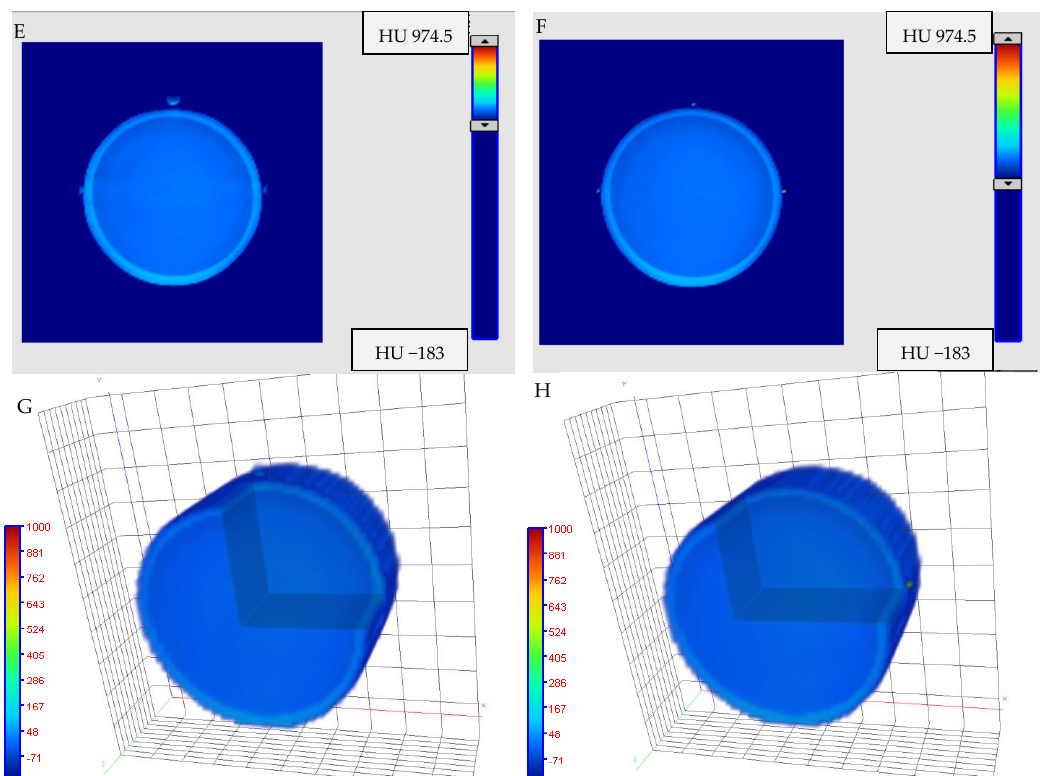
Figure 4. Two-dimensional (transversal plane, Z = −1 mm) and three-dimensional images of PH-6- DD2 container (GeVero Co.) with 5% gelatine (iCBCT, Pelvis, TrueBeam accelerator, Varian). The following markers were attached to the container at 0, 90 and 270°: steel wire commonly used as a marker in CT (1 mm thickness) ( A , C ), reflective marker spheres (Brainlab) ( B , D ), vitamin ( E ) of the shape of round capsules ( E , G ) and the shielded copper wire of the network cable (0.5 mm thickness) ( F , H ). The green circle in ( A ) indicates a cylindrical VOI of 32.8 mm in diameter and 2 mm long, applied to each scanned container with different markers. The red line in ( B ) is the position of the profiles applied to each scanned sample (see Figure 5). iCBCT images were processed with the polyGeVero-CT and polyGeVero (GeVero Co.) software packages.